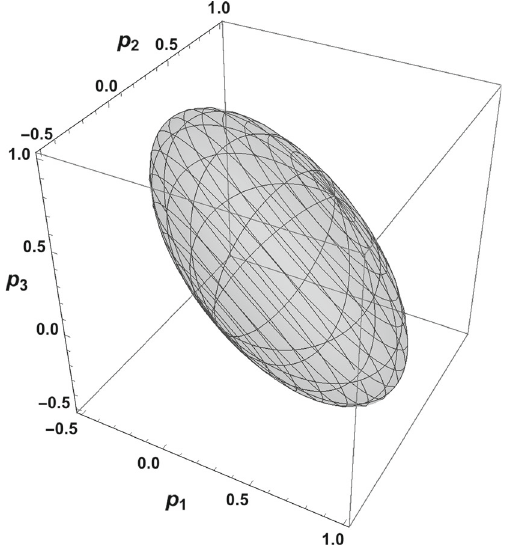
Fig. 1 Ellipsoid in the parameter space p 1 , p 2 and p 3 given by Eq. (18)